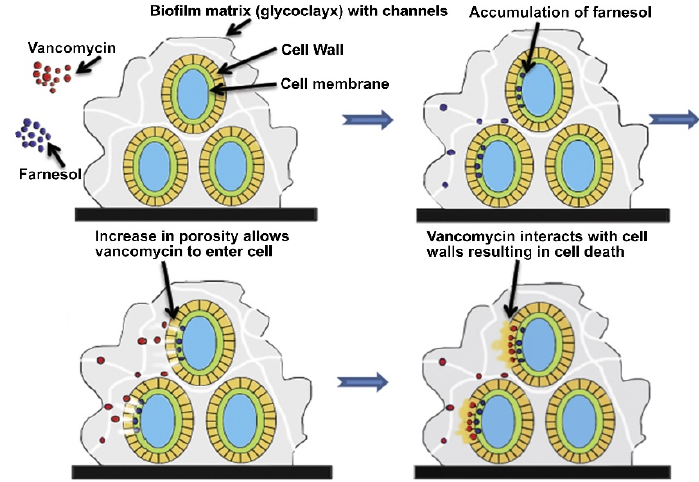
Figure 2. Farnesol adjuvant activity leading to the enhancement of vancomycin’s effectiveness [52]. Reprinted with permission from (Biomaterials). Copyright (2014) Elsevier.